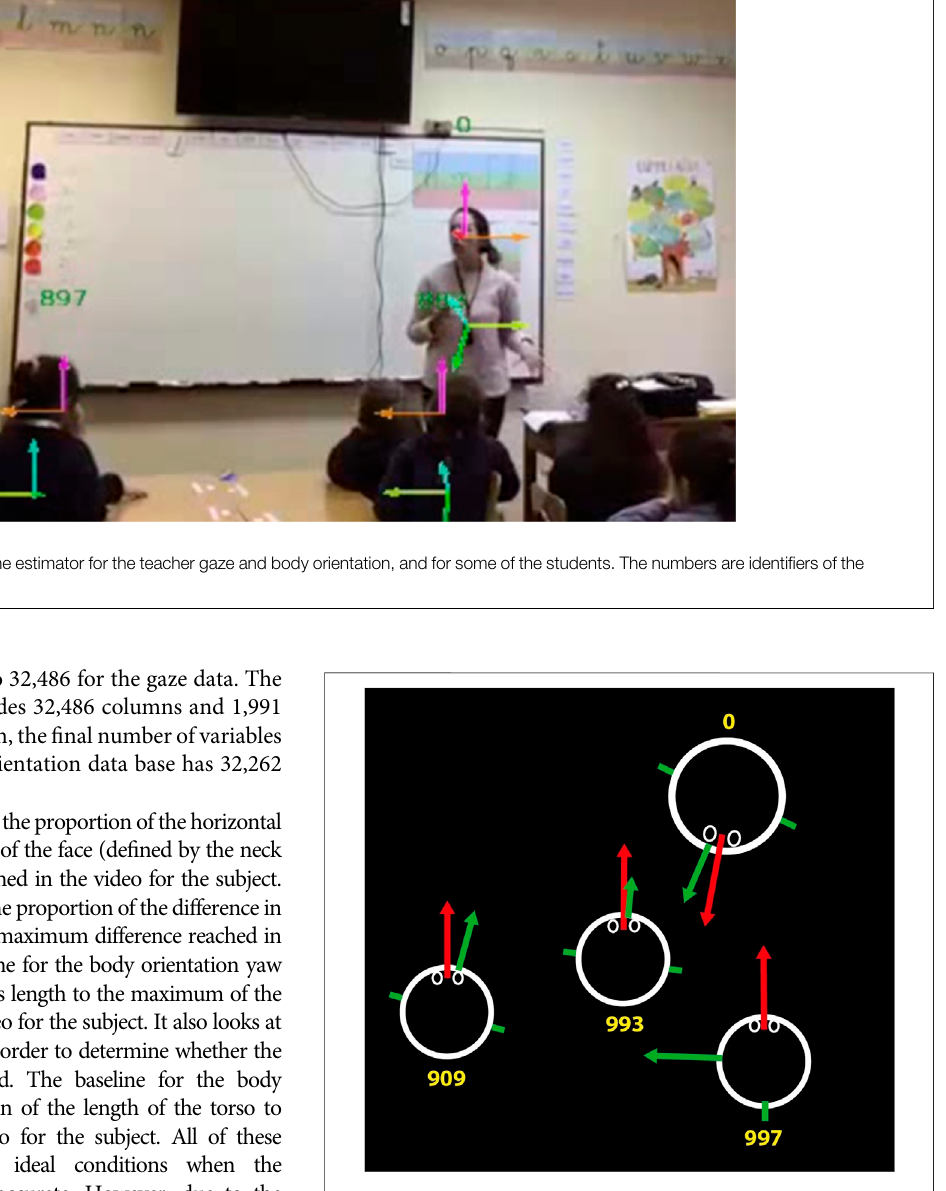
FIGURE 6 | Representation of the teacher and students. The teacher is represented by the larger circle. Red arrows indicate head orientation, and green arrows indicate body orientation, with a vector normal to the chest. The shoulders are represented by two short green